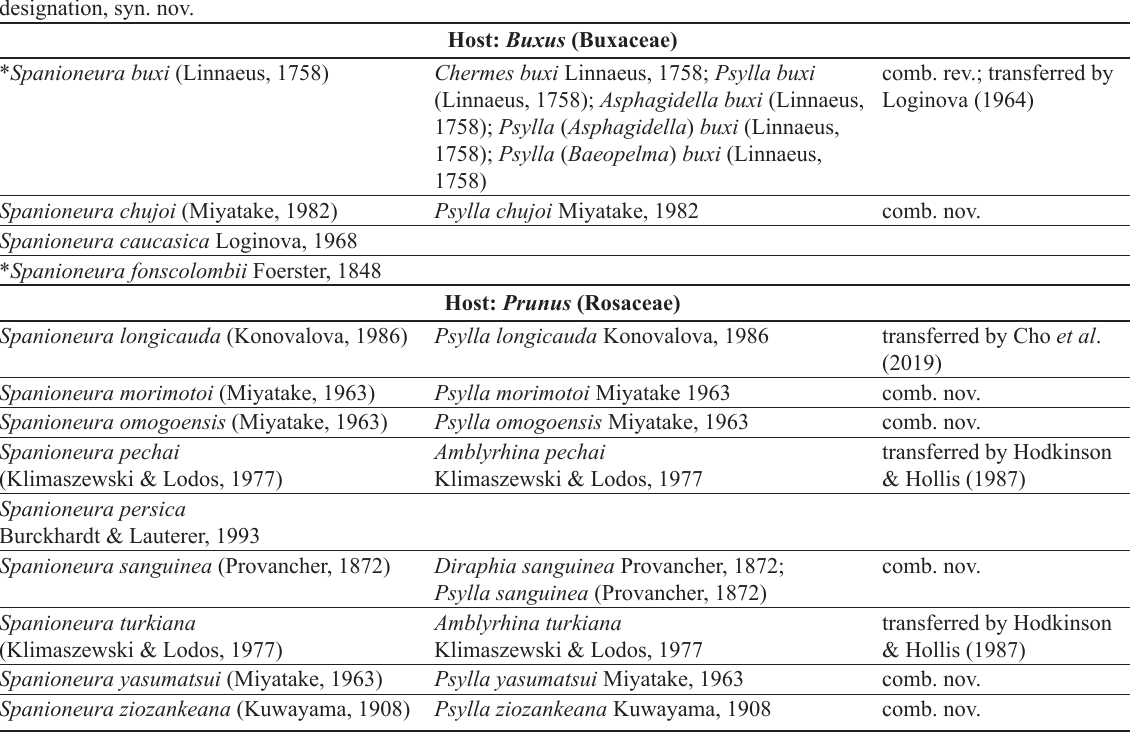
Table 4. Holarctic species in Psyllinae Latreille, 1807 associated with Buxus (Buxaceae) and Prunus (Rosaceae) referrable to Spanioneura Foerster, 1848. Taxa sampled in Percy et al . (2018) are indicated with an